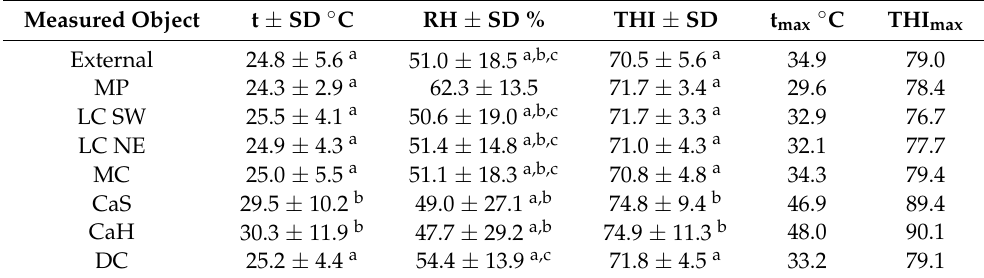
Table 1. Results of measurement and statistical comparison of parameters of thermal–humidity environment of outdoor air and thermal–humidity environment of indoor air in all investigated buildings calculated for measured 4 days of the hot summer period (HSP). Different superscript letters ( a, b, c ) are a sign of a significant difference ( ANOVA ; Tukey’s HSD test ; p ≤ 0.05) between the measured values in the individual columns. Identical superscript letters for numbers in a column indicate that there is no statistically significant difference between measured values in compared objects. Measured Object